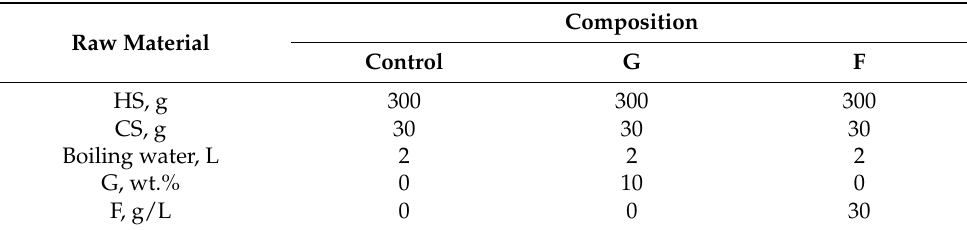
Table 1. Composition of BcBs. HS—hemp shives; CS—corn starch G—expandable graphite; F-Flovan. Raw Material